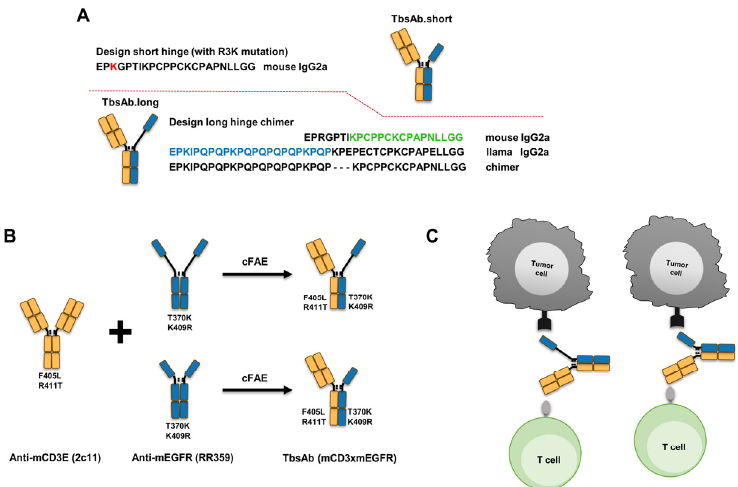
Figure 1. Preparation of Fab x sdAb-Fc TbsAbs with different hinge designs. ( A ) Schematic diagrams of two types of Fab x sdAb-Fc TbsAbs: TbsAb.long, TbsAb.short. ( B ) Schematic illustration of mCD3E × mEGFR TbsAbs generated by the duobody platform. ( C ) Schematic diagrams of tumor cell eliminated by mCD3E × mEGFR TbsAbs.